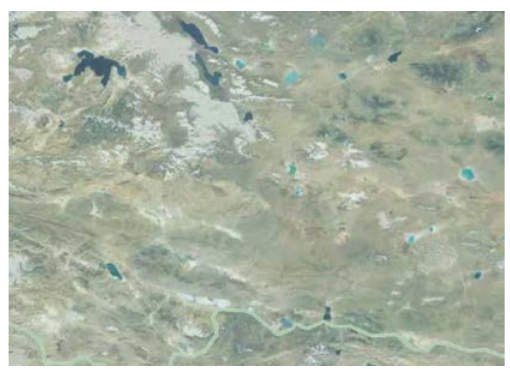
Figure 6. schematic diagram of test range